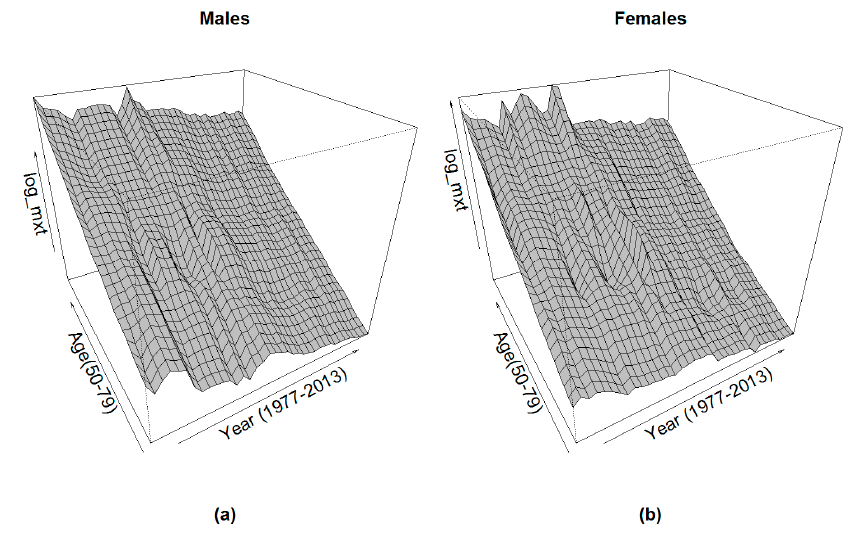
Figure 5. Age-specific death rates of Algerian: males ( a ); and females ( b ). Period: 1977–2014. Data Source: Annual publications of ONS / Missing data: Flici (2014) / Single age data: Interpolated by the Karup–King method.